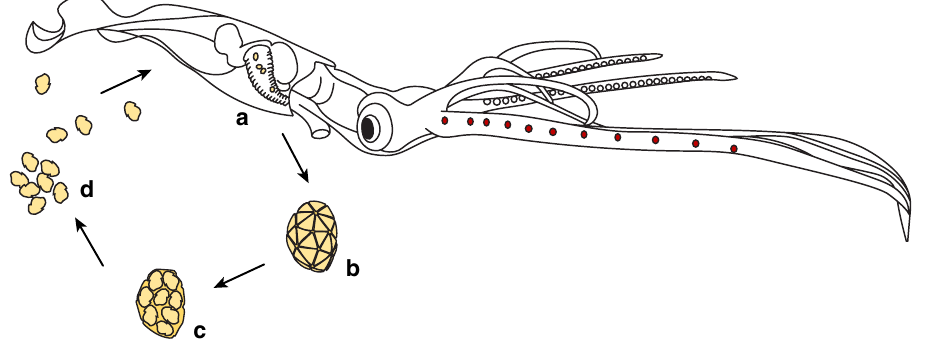
Figure 6. Theorized life cycle of Hochbergia moroteuthensis . ( a ) The vegetative trophont (feeding life stage) grows without cellular division on the cephalopod’s gills. ( b ) The mature trophont detaches and ( c ) divides into motile dinospores, ( d ) free to infect new hosts in the water column. Illustration ( b ) trophont adapted from Shinn & McLean 30